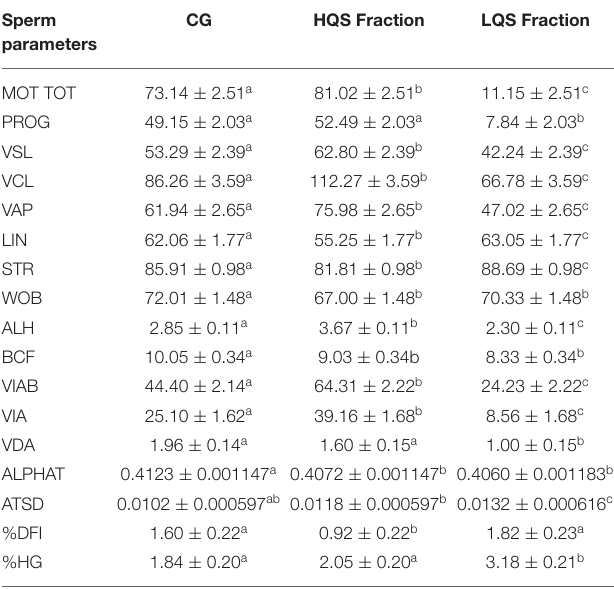
TABLE 2 | Sperm quality variables assessed after thawing (Control Group = CG) and after Percoll separation in High and Low Quality Sperm Fraction (HQS, LQS). Sperm